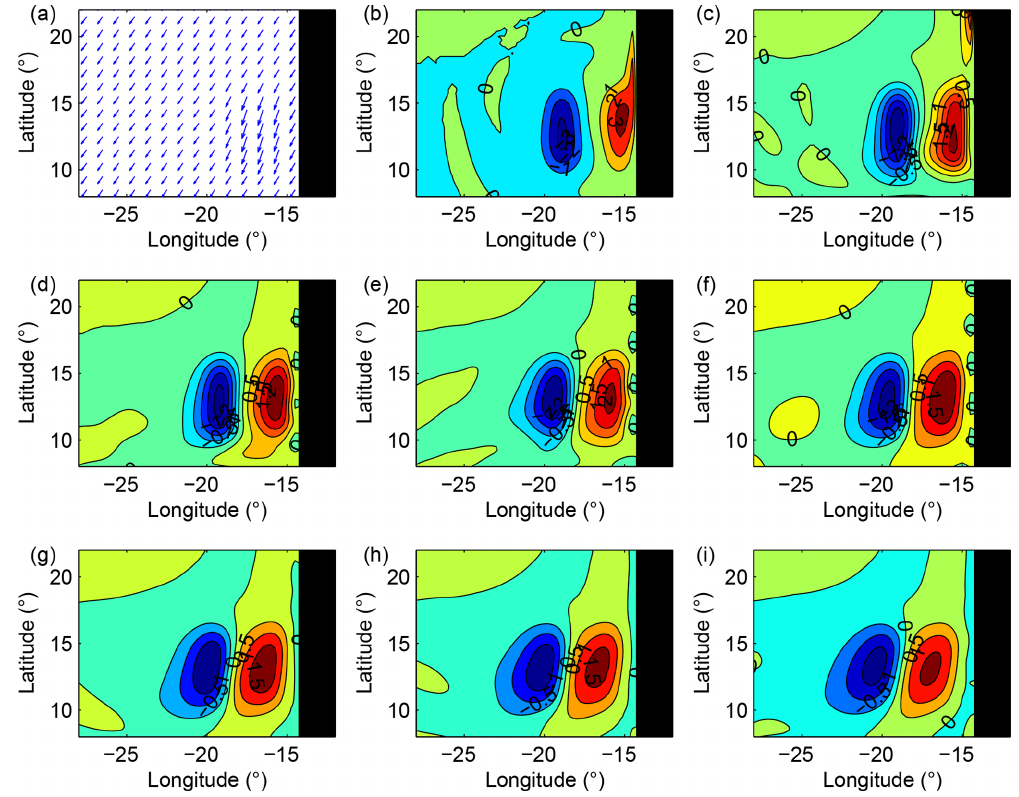
Figure 5. Solution obtained for the same conditions as in Fig. 4 for a straight coastline. Note that the mean wind stress is added to the wind stress anomaly in panel (a) . A Rossby wave is still generated, but the halting of the signal due to the cape is no longer observed. The latitudinal extent of the wave east of 19 ◦ W is thus nearly twice larger than in the previous case.